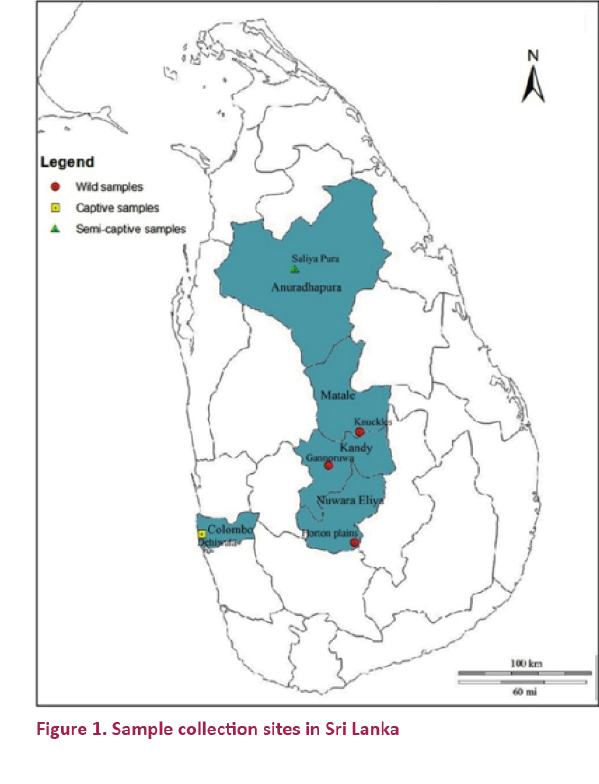
Ffigure 1. Sample collecfion sfittes fin Srfi